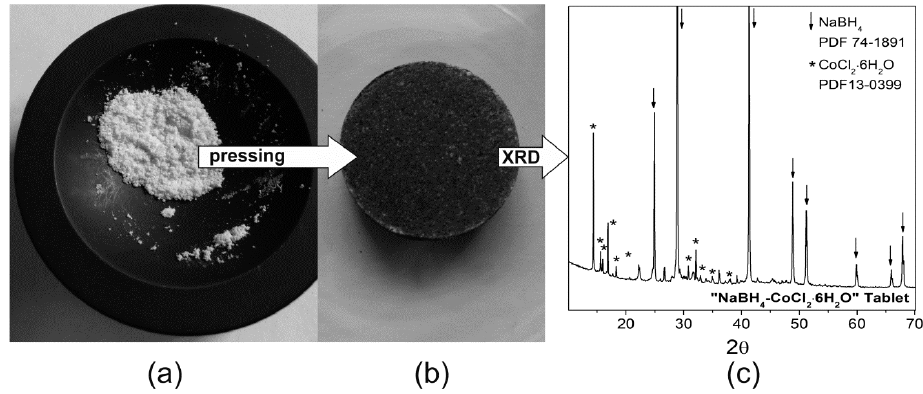
Figure 1. Preparation of the solid-state NaBH 4 /Co composite: ( a ) mechanical mixture of sodium borohydride with cobalt chloride hexahydrate; ( b ) tablet of solid-state NaBH 4 /Co composite; ( c ) diffraction pattern of a freshly-prepared tablet. Compressing pressure–13.5 kgf · cm − 2 . Molar ratio NaBH 4 :Co = 60:1.